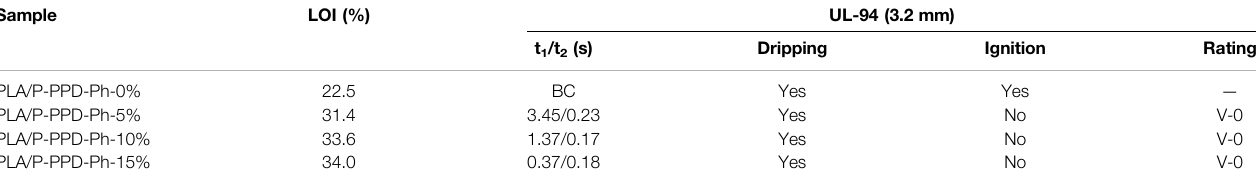
TABLE 1B | (B) UL-94 and LOI test results for PLA-conjugated fl ame-retardant composites. Sample LOI